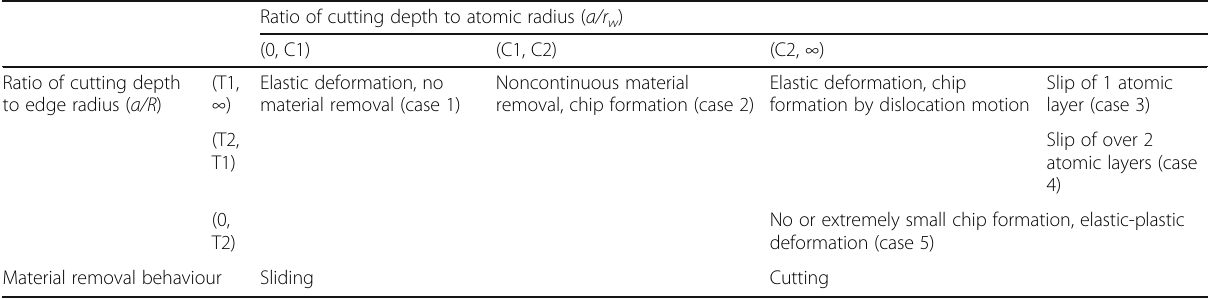
Material removal